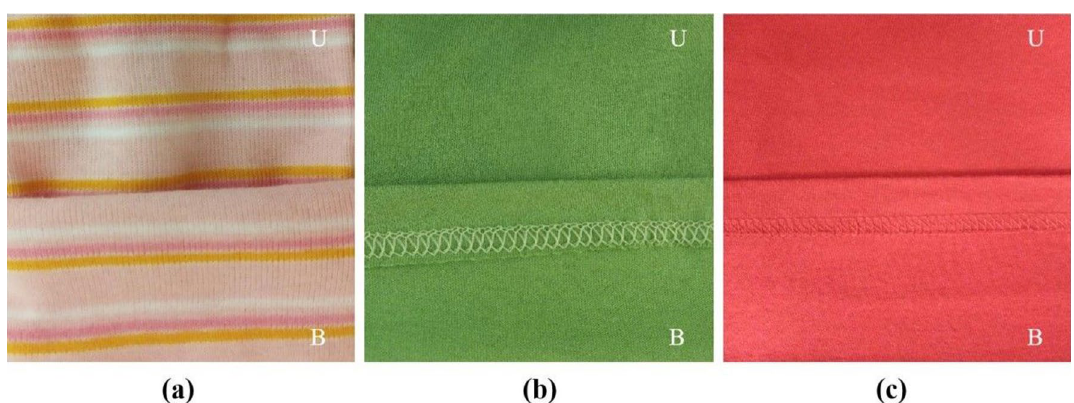
Figure 3. Tested material—textiles, for which samples C1 ( a ), C2 ( b ) and C3 ( c ) were collected; U upper, B bottom. Source: Author’s own